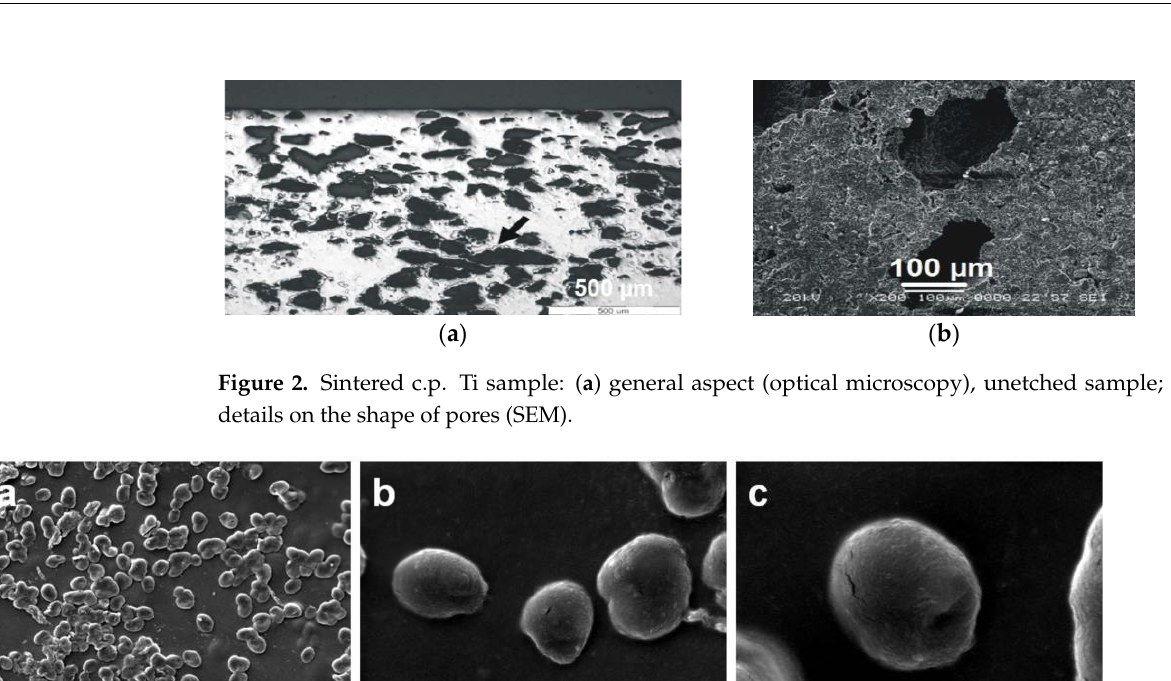
Figure 3. SEM images of multilayer BSA gel microparticles, magnification of 1000× ( a ), 5000× ( b ) and 10,000× ( c ).